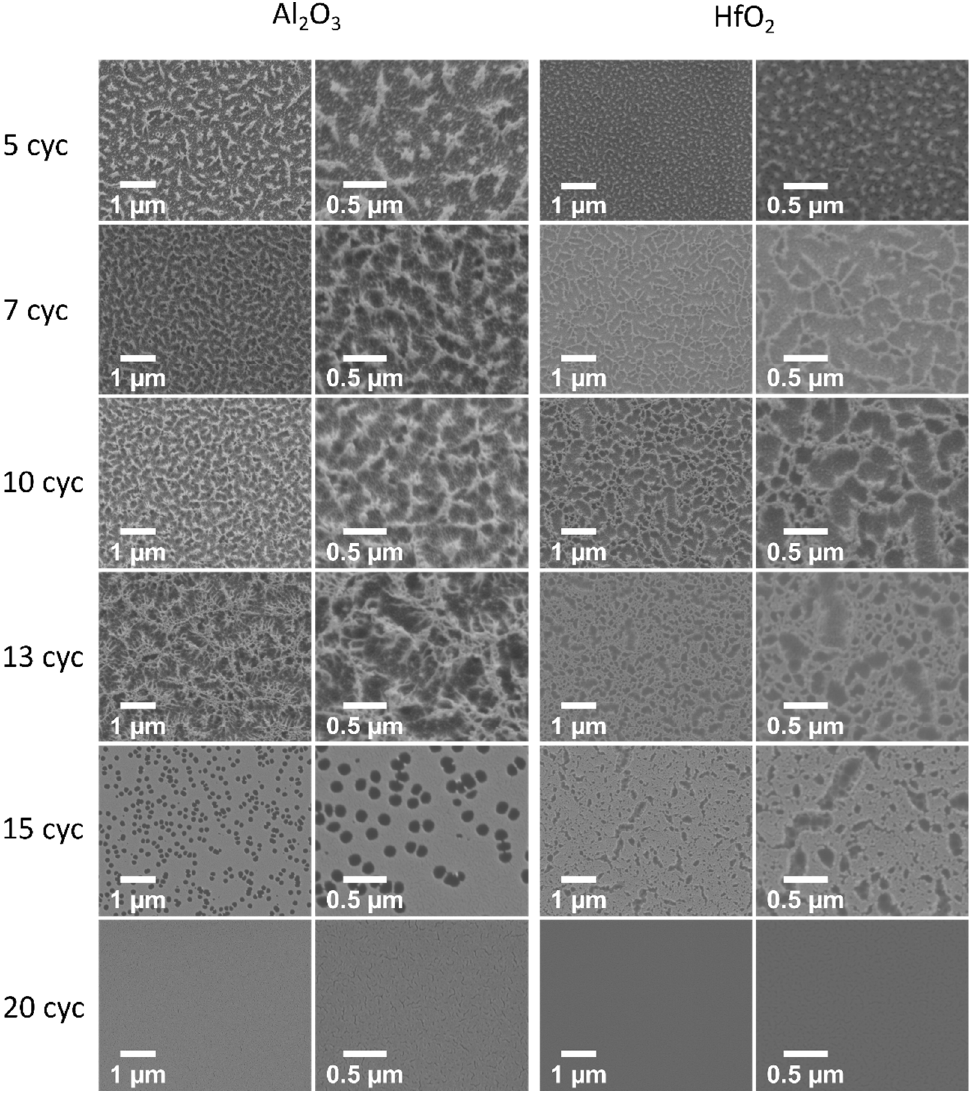
Figure 3. FEG–SEM images showing the evolution of Al 2 O 3 and HfO 2 ALD nucleation on polyimide after 5 min of RIE. The ALD deposition processes had a GPC of 1.20 ± 0.02 Å/cycle for Al 2 O 3 and The ALD deposition processes had a GPC of 1.20 ± 0.02 Å/cycle for Al 2 O 3 and 1.16 ± 0.01 Å/cycle for HfO 2 on 1.16 ± 0.01 Å/cycle for HfO 2 on Si.